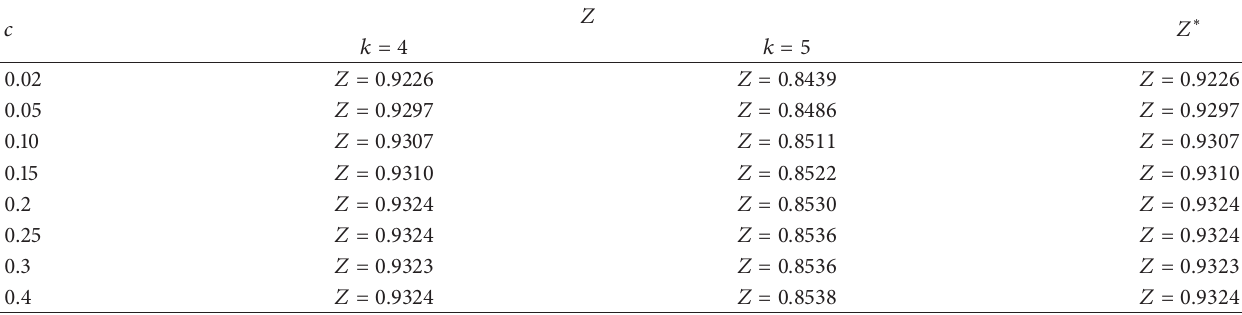
Table 5: The influence of 𝑐 on scheduling result.